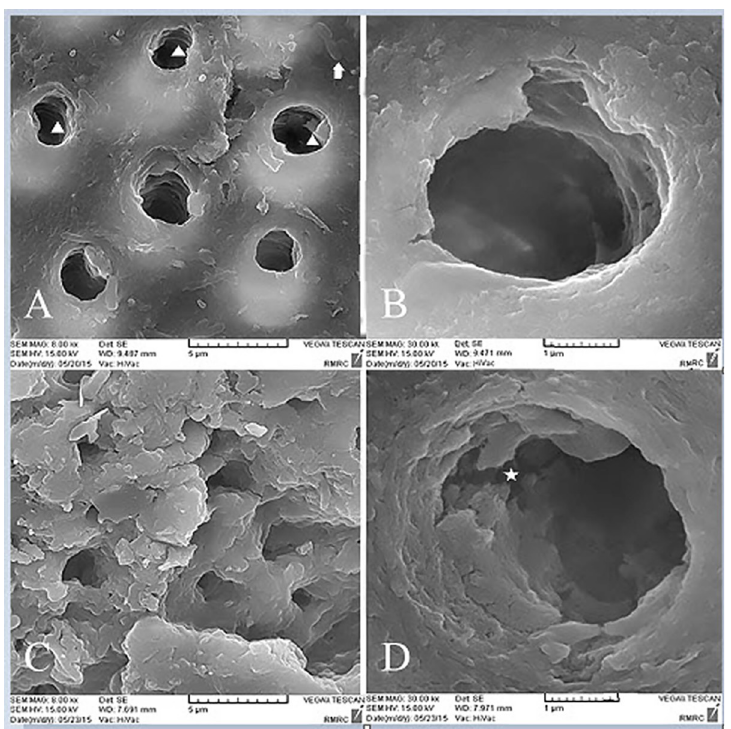
Fig 3. SEM images of the control group. A,B. Before acidic challenge. C,D. After Acidic challenge. Arrow shows bacterial cell bodies, triangle shows caries crystal, and star shows the